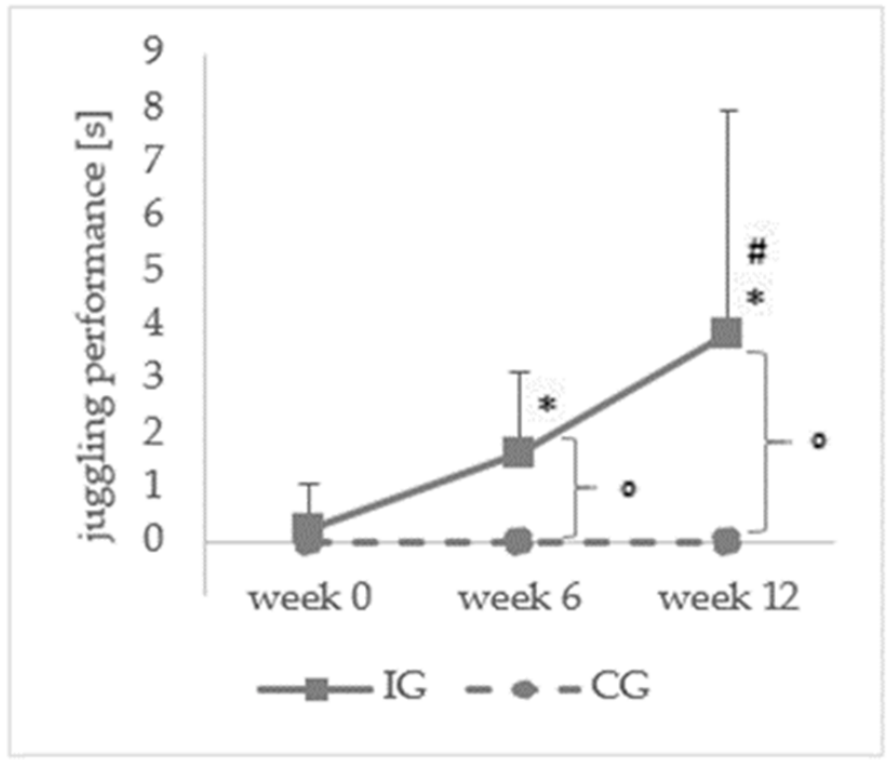
Figure 3. Means and standard deviations of the 3-ball-cascade absolute time before (week 0), during (week 6), and after (week 12) for the intervention group. * significant difference to week 0 for the IG, # significant difference to week 6 for the IG; ◦ significant difference between IG and CG; KG: n = 10.